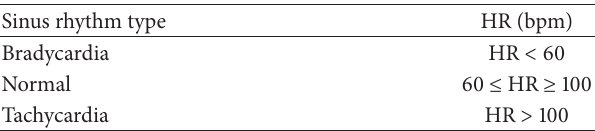
Table 2: Thresholds for supraventricular sinus rhythm classifica-